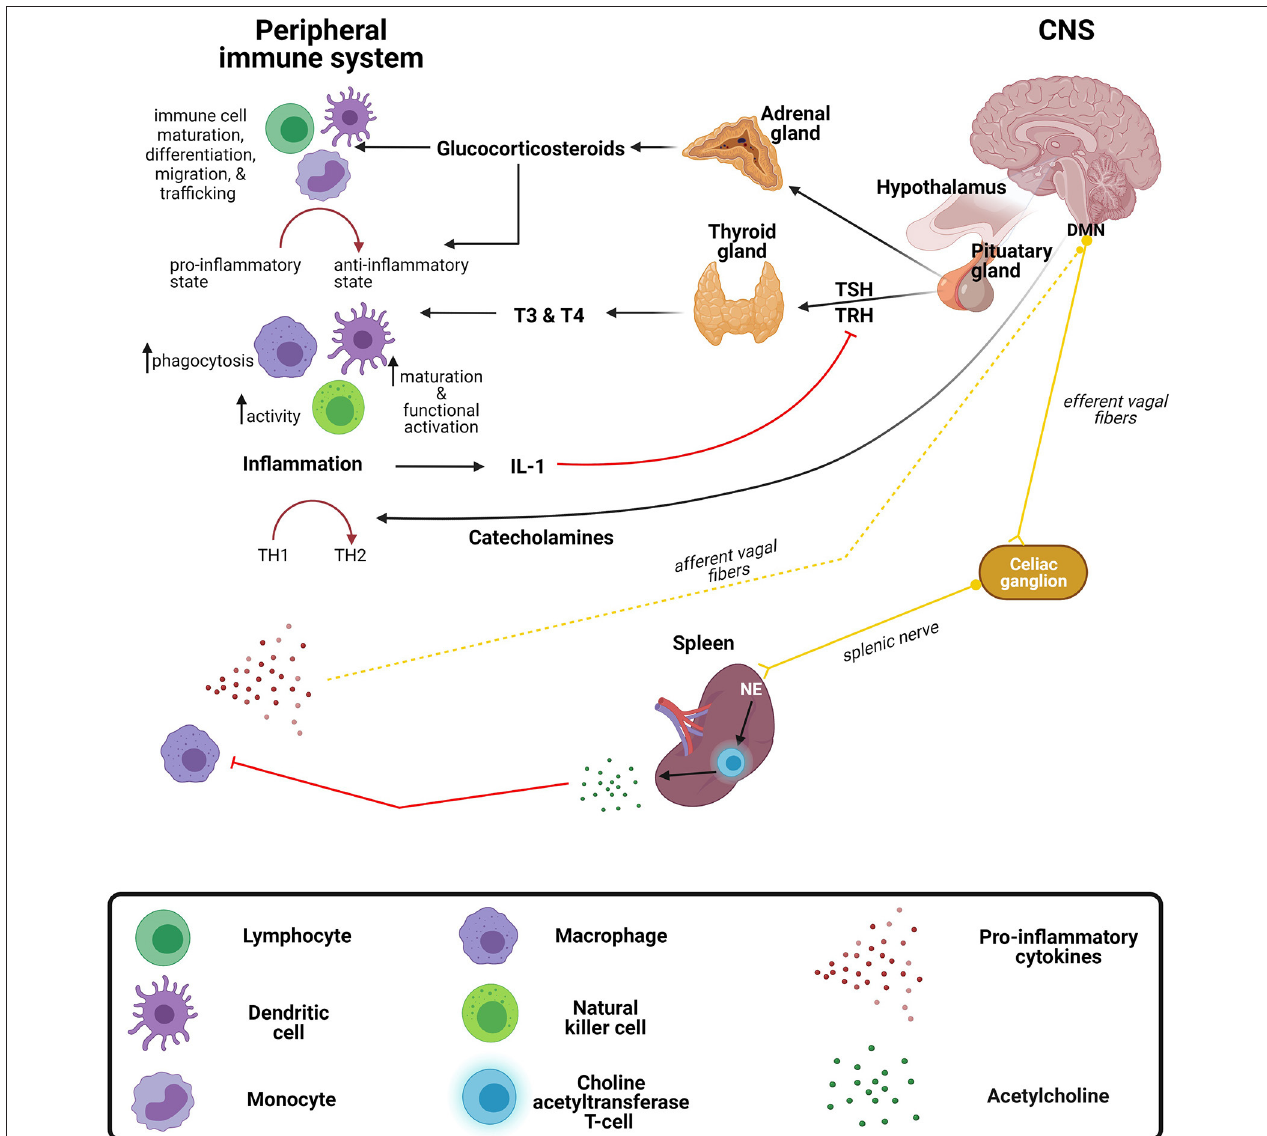
FIGURE 3 | Crosstalk between the peripheral immune system and central nervous system. The brain exerts immunomodulatory effects on the immune system through the release of (1) corticosteroids and catecholamines from the hypothalamic-pituitary adrenal (HPA) axis and (2) thyroid hormones from the hypothalamic-pituitary thyroid (HPT) axis. The peripheral immune system regulates the central nervous system (CNS) via the release of inflammatory mediators and signaling via the vagus nerve. DMN, dorsal motor nucleus of the vagus nerve; IL-1, interleukin-1; NE, norepinephrine; TH, T-helper; TRH, thyroid-releasing hormone; TSH, thyroid-stimulating hormone; T4, thyroxine; T3,